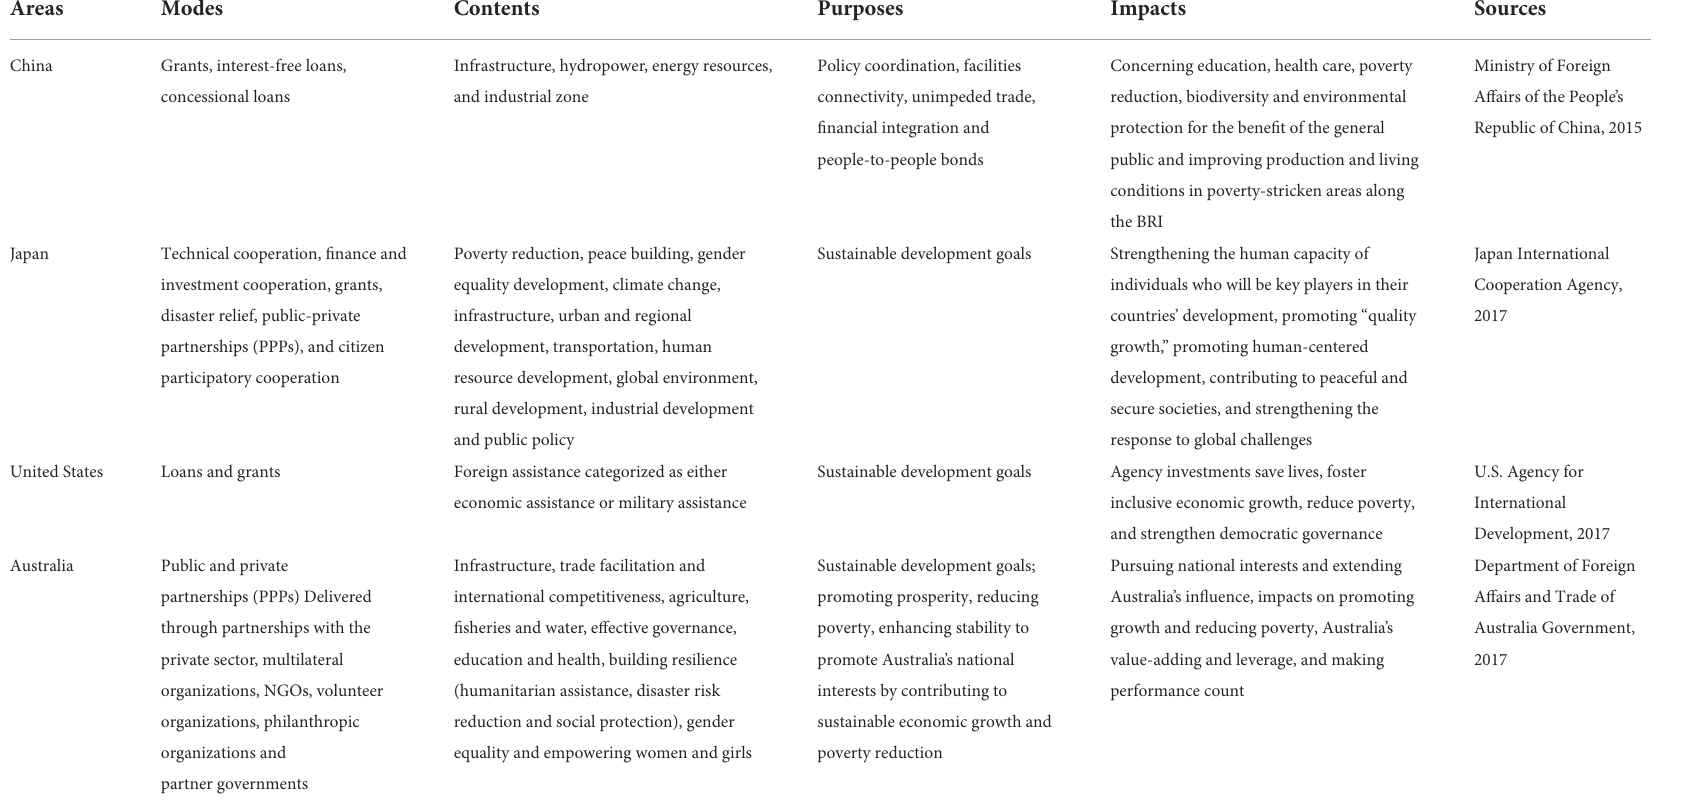
TABLE 4 Similarities and differences in foreign aid between developed countries and